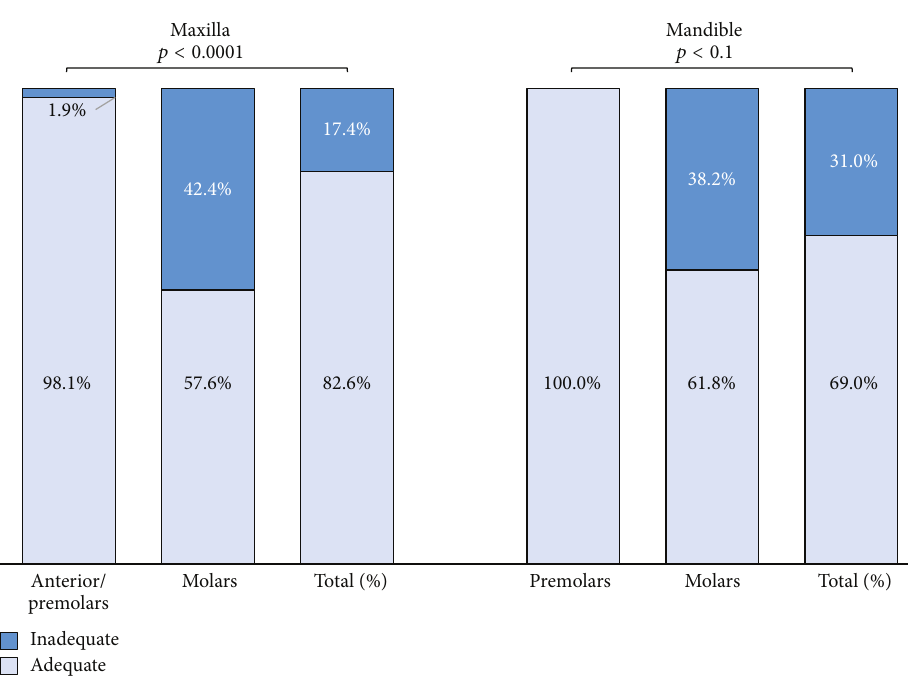
Figure 3: Density quality (%) in maxillary and mandibular root canal-filled